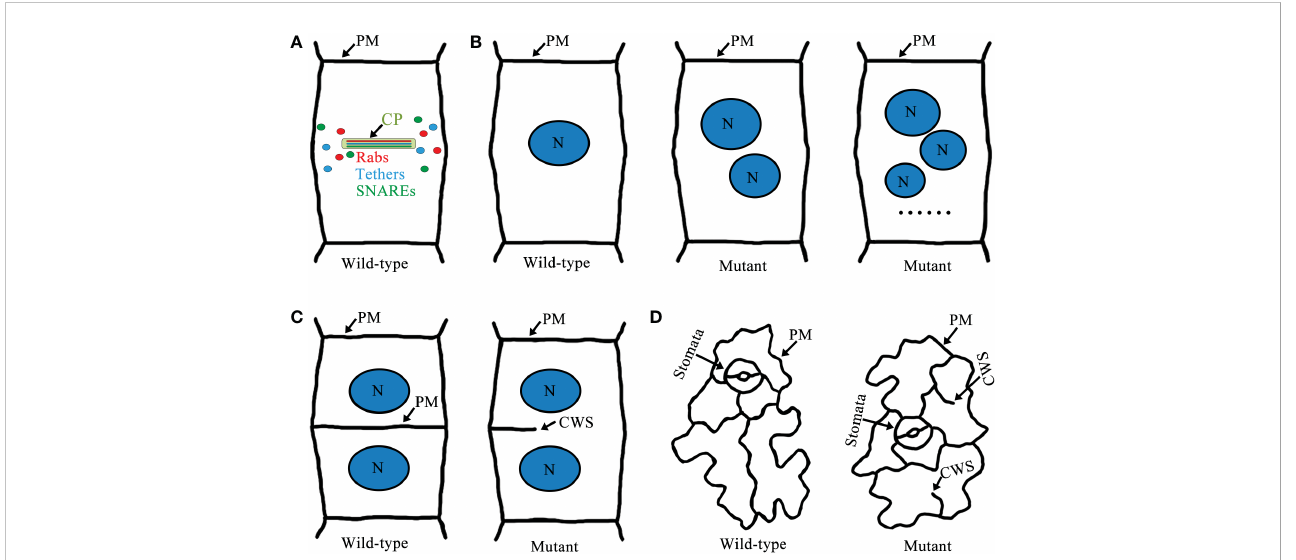
FIGURE 3 A schematic model of Rab GTPases, tethers, SNAREs cell plate localization and cytokinesis-defective mutants in Arabidopsis . (A) Localization of Rab GTPases, tethers, and SNAREs in the cell plate. (B) Wild-type root epidermal cells of Arabidopsis have normal cytokinesis and only one nucleus per cell. In cytokinesis-defective mutants there are two or more nuclei per cell. (C) Wild-type root epidermal cells have intact cell walls, but defects in cell plate formation in cytokinesis-defective mutants lead to the formation of cell wall stubs. (D) Wild-type cotyledon epidermal cells are intact cells with clear outlines. However, cytokinesis-defective mutants often have cell wall stubs. Abbreviations: CP, cell plate; N, nucleus; PM, plasma membrane; and CWS, cell wall stubs.